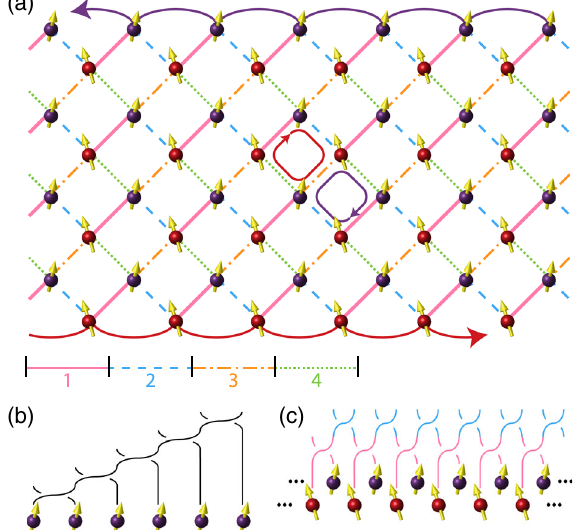
FIG. 1. Various SWAP circuits considered. (a) A Floquet phase with counterpropagating translation operators localized at the two edges can be built by applying four layers of SWAP gates, as indicated by 1 to 4. (b) The translation operator for the six-site example has depth five. Generally, it will have an infinite circuit depthinthe thermodynamiclimit. (c)Apair ofcounterpropagating translation operators, however, can be realized with depth